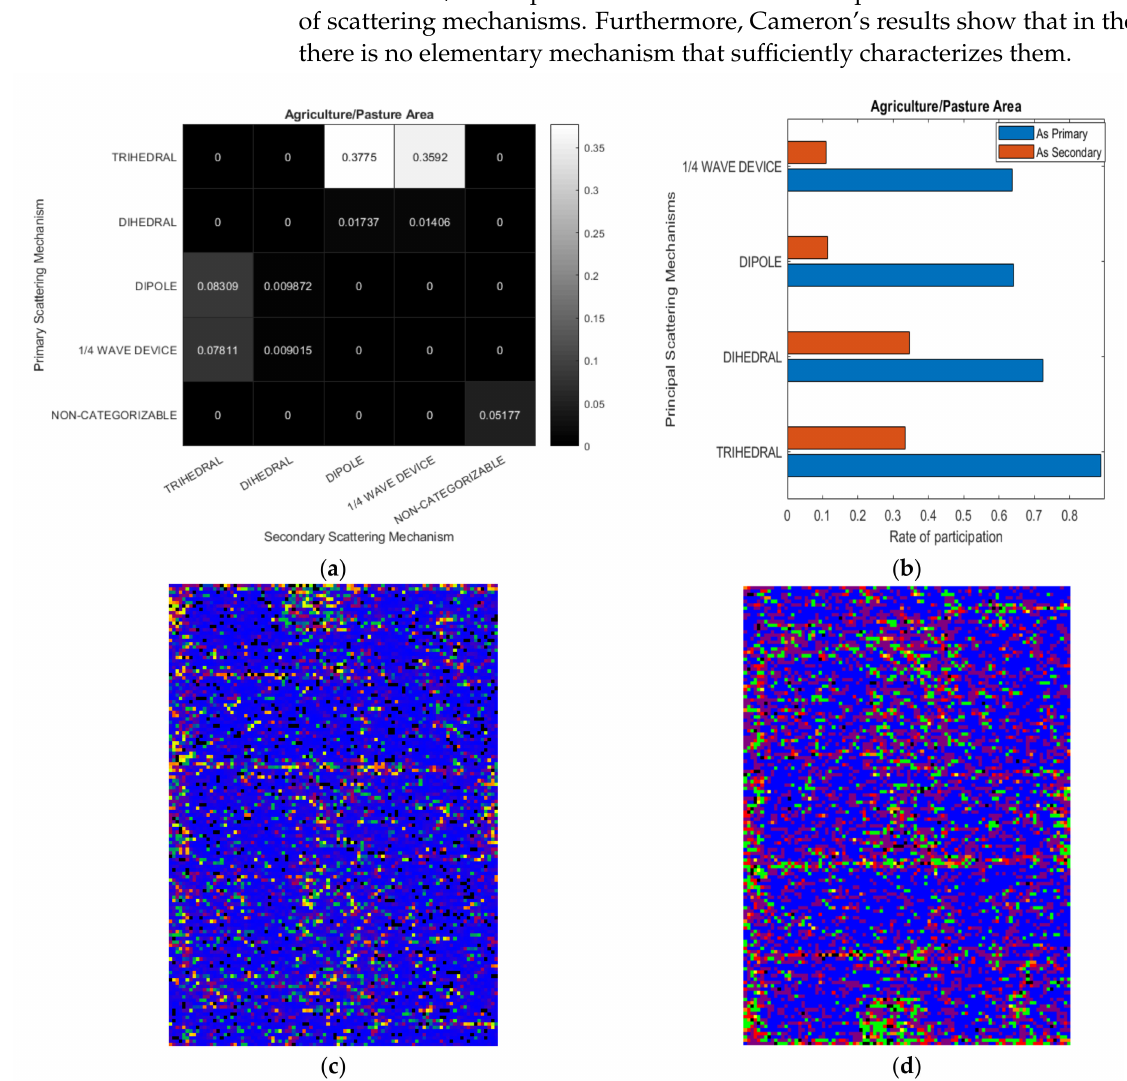
Figure 10. ( a ) heatmap of primary-secondary scattering pairs and ( b ) bar diagram with the rate of contribution (strength) either as primary or secondary scatterer for each mechanism in agricul- ture/pasture area. ( c ) color representation of each PolSAR cell using the double scatterer method. ( d ) color representation of each PolSAR cell using the Cameron’s CTD